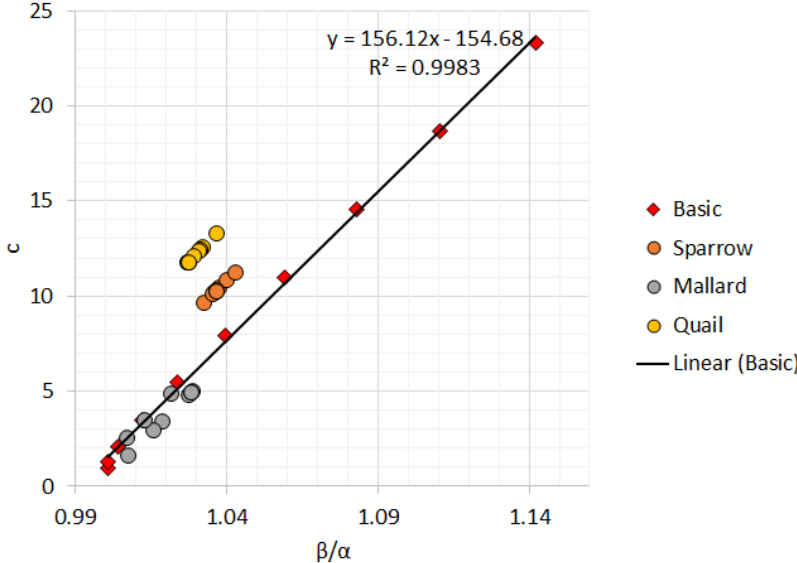
Figure 5. Graph of the function c = f ( β / α ) for different types of eggs.